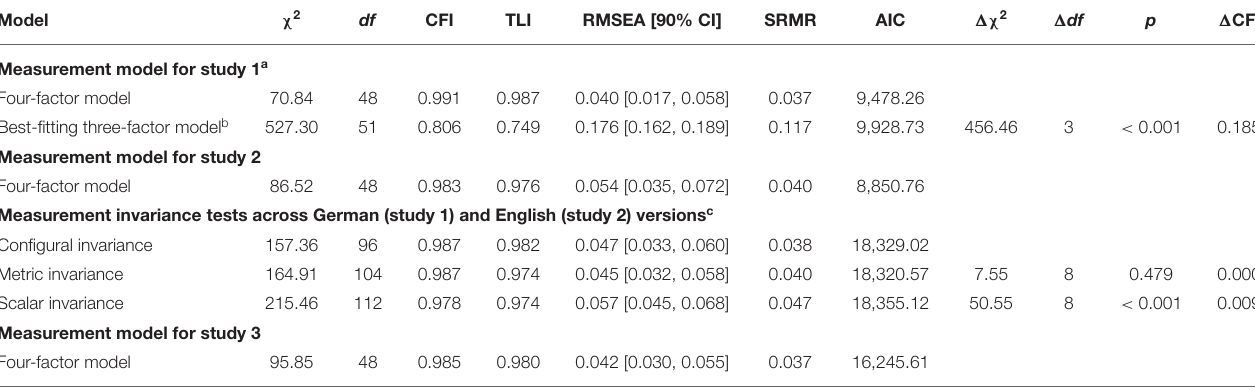
TABLE 3 | Fit indices for measurement models in and measurement invariance tests across the samples of the three studies. Model χ 2 df CFI TLI RMSEA [90% CI] 1